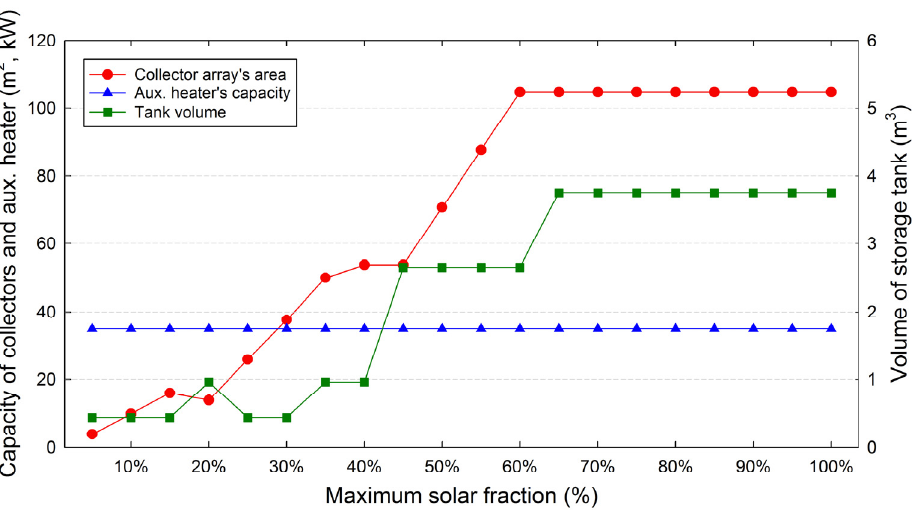
Figure 7. Variation of component sizes at the different maximum solar